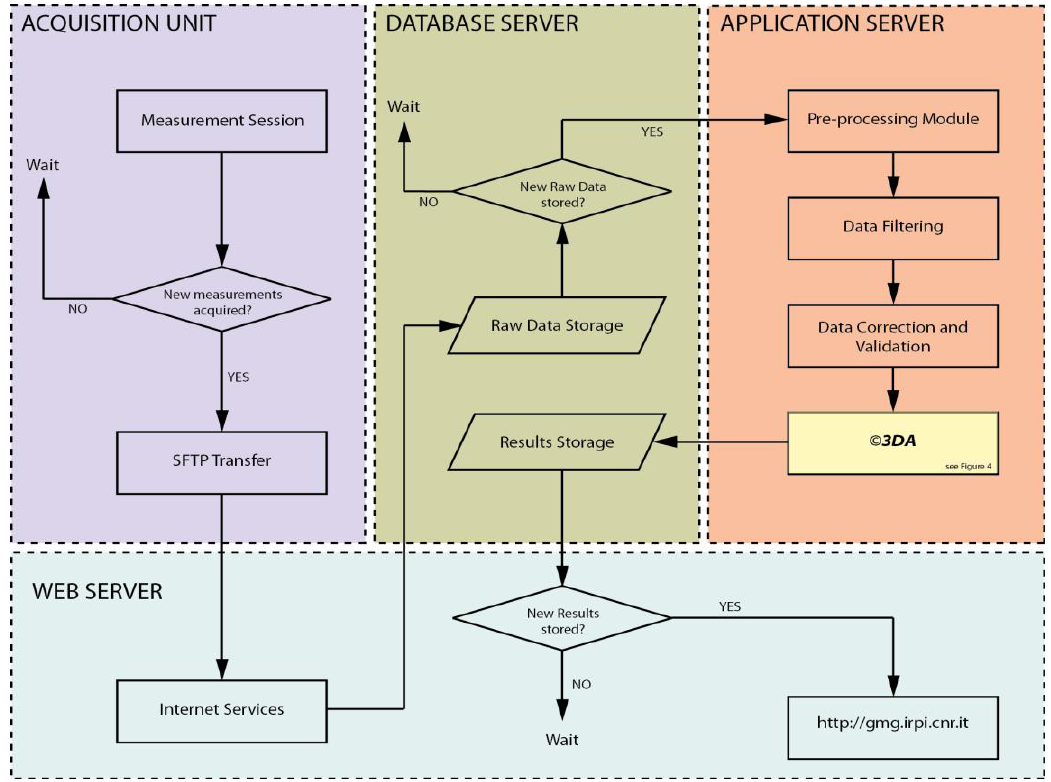
Figure 3. Detailed Flow Chart of the ADVICE key